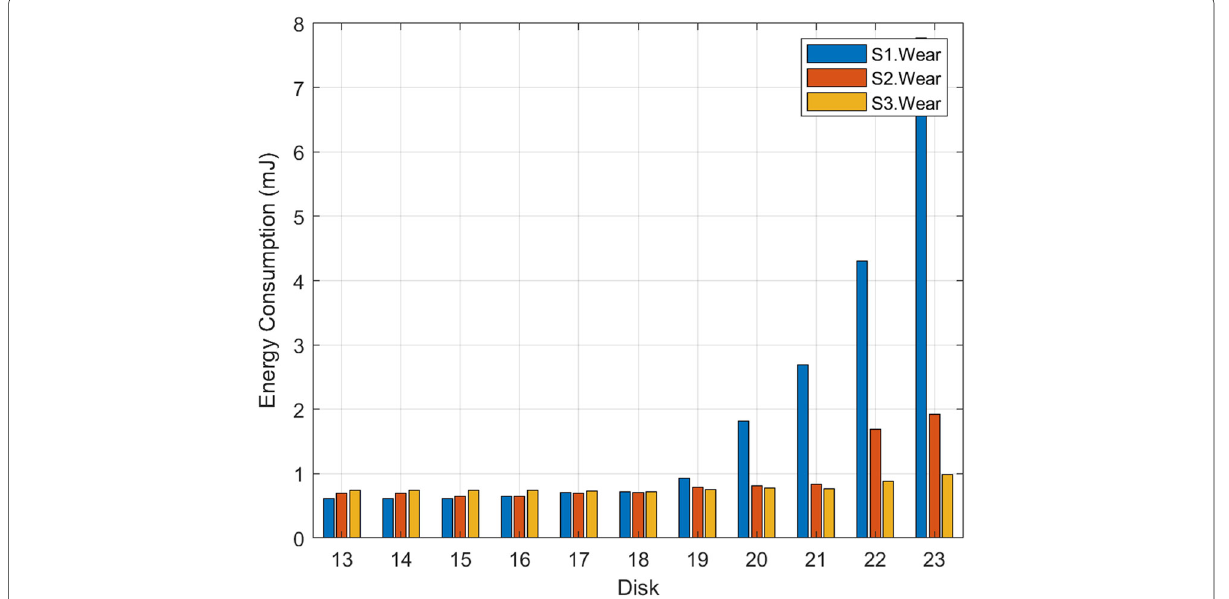
Fig. 6 Comparing the energy consumption of Smart Watch according to the number of